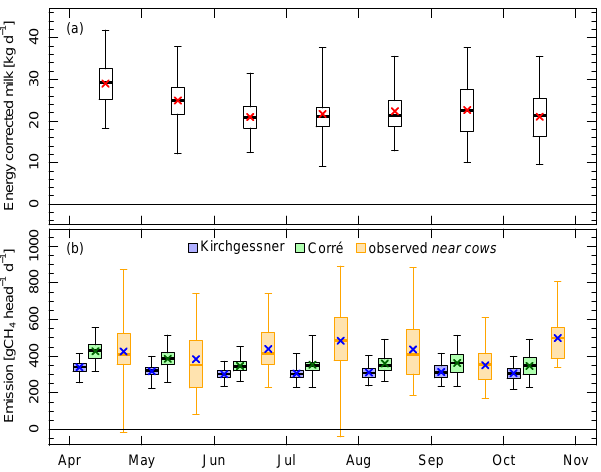
Figure 12. Histogram of cow emissions for near cows and far cows for the GPS method (according to Eqs. 3 and